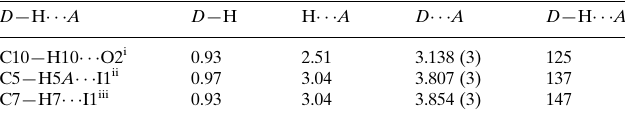
Hydrogen-bond geometry (A˚ , (cid:4)